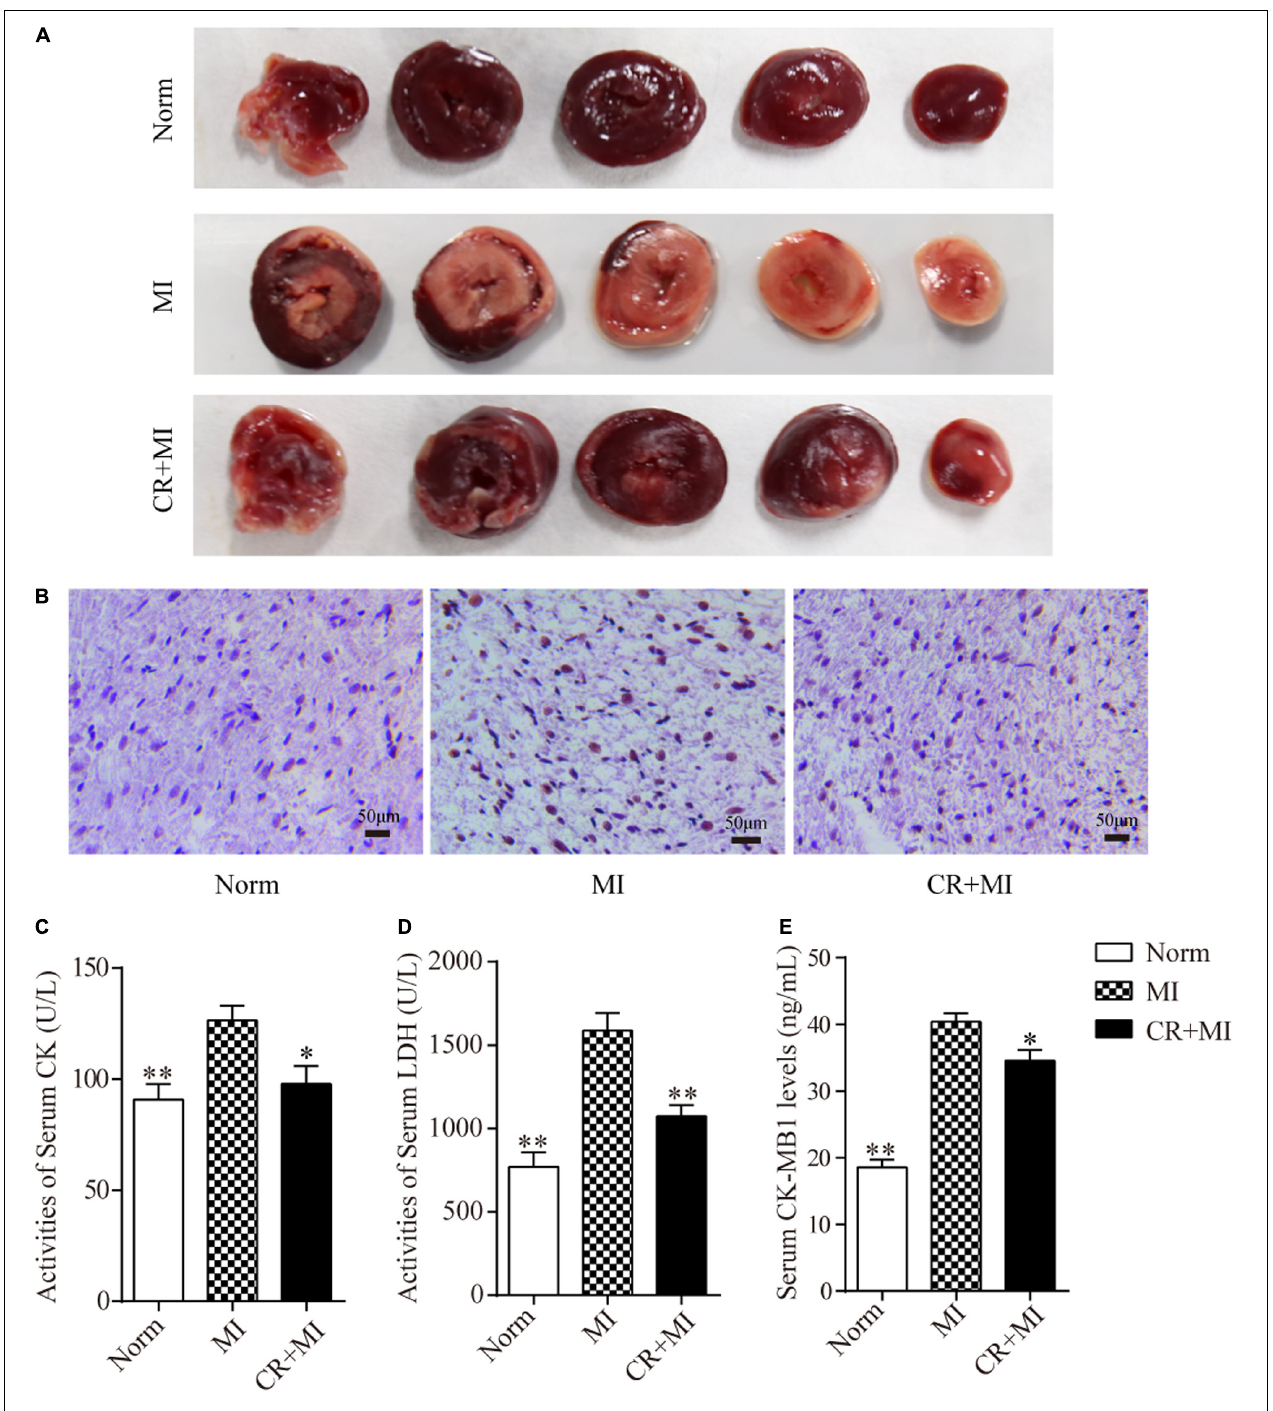
FIGURE 2 | Effects of CR pretreatment on myocardial ischemic injury. (A) Representative morphological images of myocardial tissue in norm, MI, and CR + MI groups after TTC staining. (B) TUNEL assay of myocardial tissues in norm, MI, and CR + MI groups. Brown staining of the nucleus indicates apoptosis. (C) The activities of serum CK were determined by CK assay kit in norm, MI, and CR + MI groups. (D) The activities of serum LDH were examined by LDH activity detection kit in norm, MI, and CR + MI groups. (E) The levels of serum CK-MB1 were measured by CK-MB1 ELISA kit in norm, MI, and CR + MI groups. The data are presented as the mean ± SEM ( n = 6). * P < 0.05, ** P < 0.01 compared with the MI group.